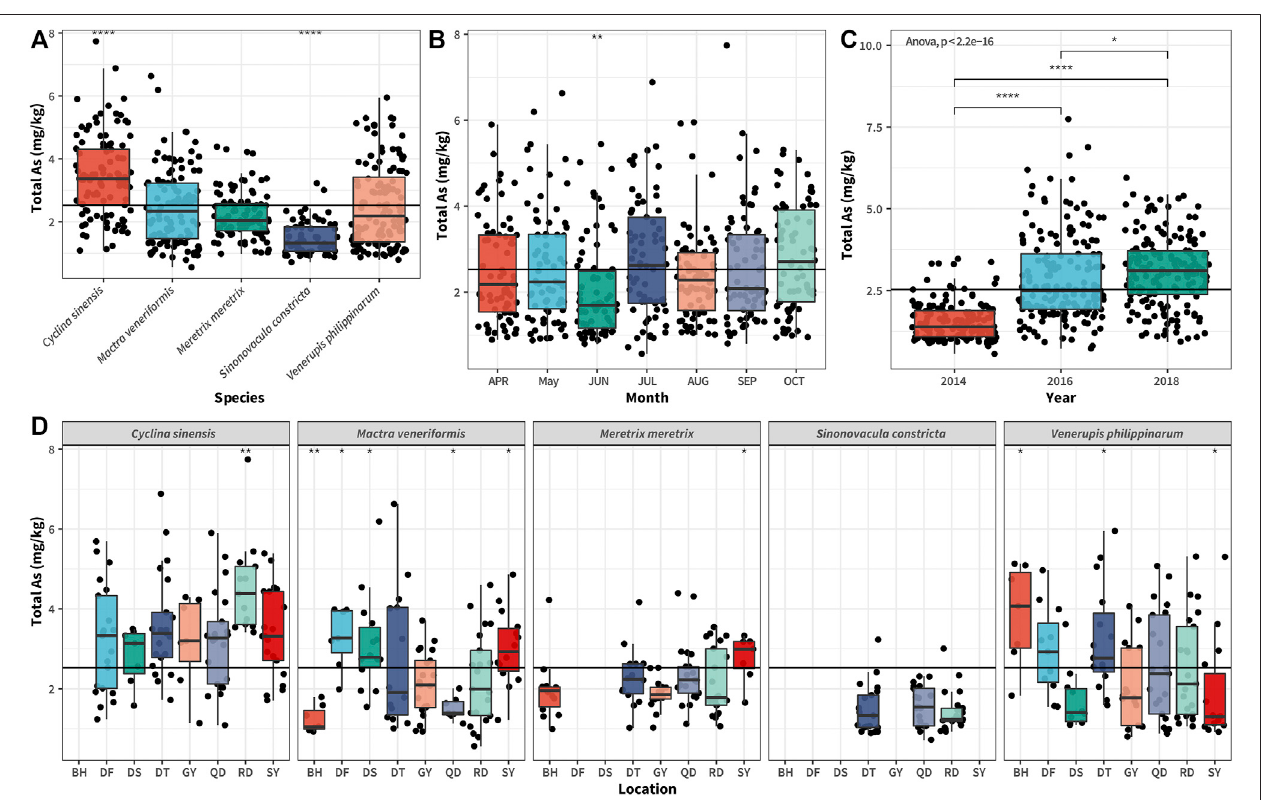
FIGURE2| BoxplotoftotalAsconcentrationsindifferentclamspecies (A) ,collectingmonths (B) ,samplingyears (C) ,andlocations (D) inJiangsuprovince,China. Thebottomandtopoftheboxesrepresentthe25thand75thpercentiles,whileerrorbarsrepresentthe5thand95thpercentiles.Thesolidlinesinsidetheboxrepresent the median tAs concentrations. In all panels, data were analyzed using one-way analysis of variance (ANOVA), where * p < 0.05; ** p < 0.01; and **** p < 0.0001.